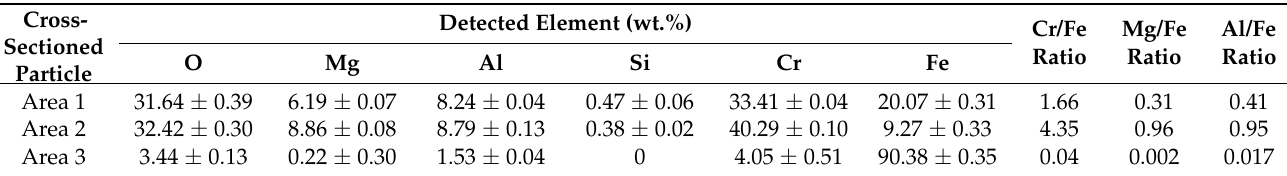
Figure 5. Backscattered electron SEM micrograph of a representative polished cross-sectioned chromite particle thermally treated at 1100 °C for 30 min. Table 4. SEM–EDX (wt.%) of the center (Area 1), transition phase (Area 2), and rim (Area 3) of a representative particle thermally treated at 1100 °C for 30 min, as well as the respective Cr/Fe, Mg/Fe, and Al/Fe ratio for each of the areas. A minimum of eight randomly selected particles were considered for EDX analysis and between three to five areas were analyzed with the averages and standard deviations indicated.